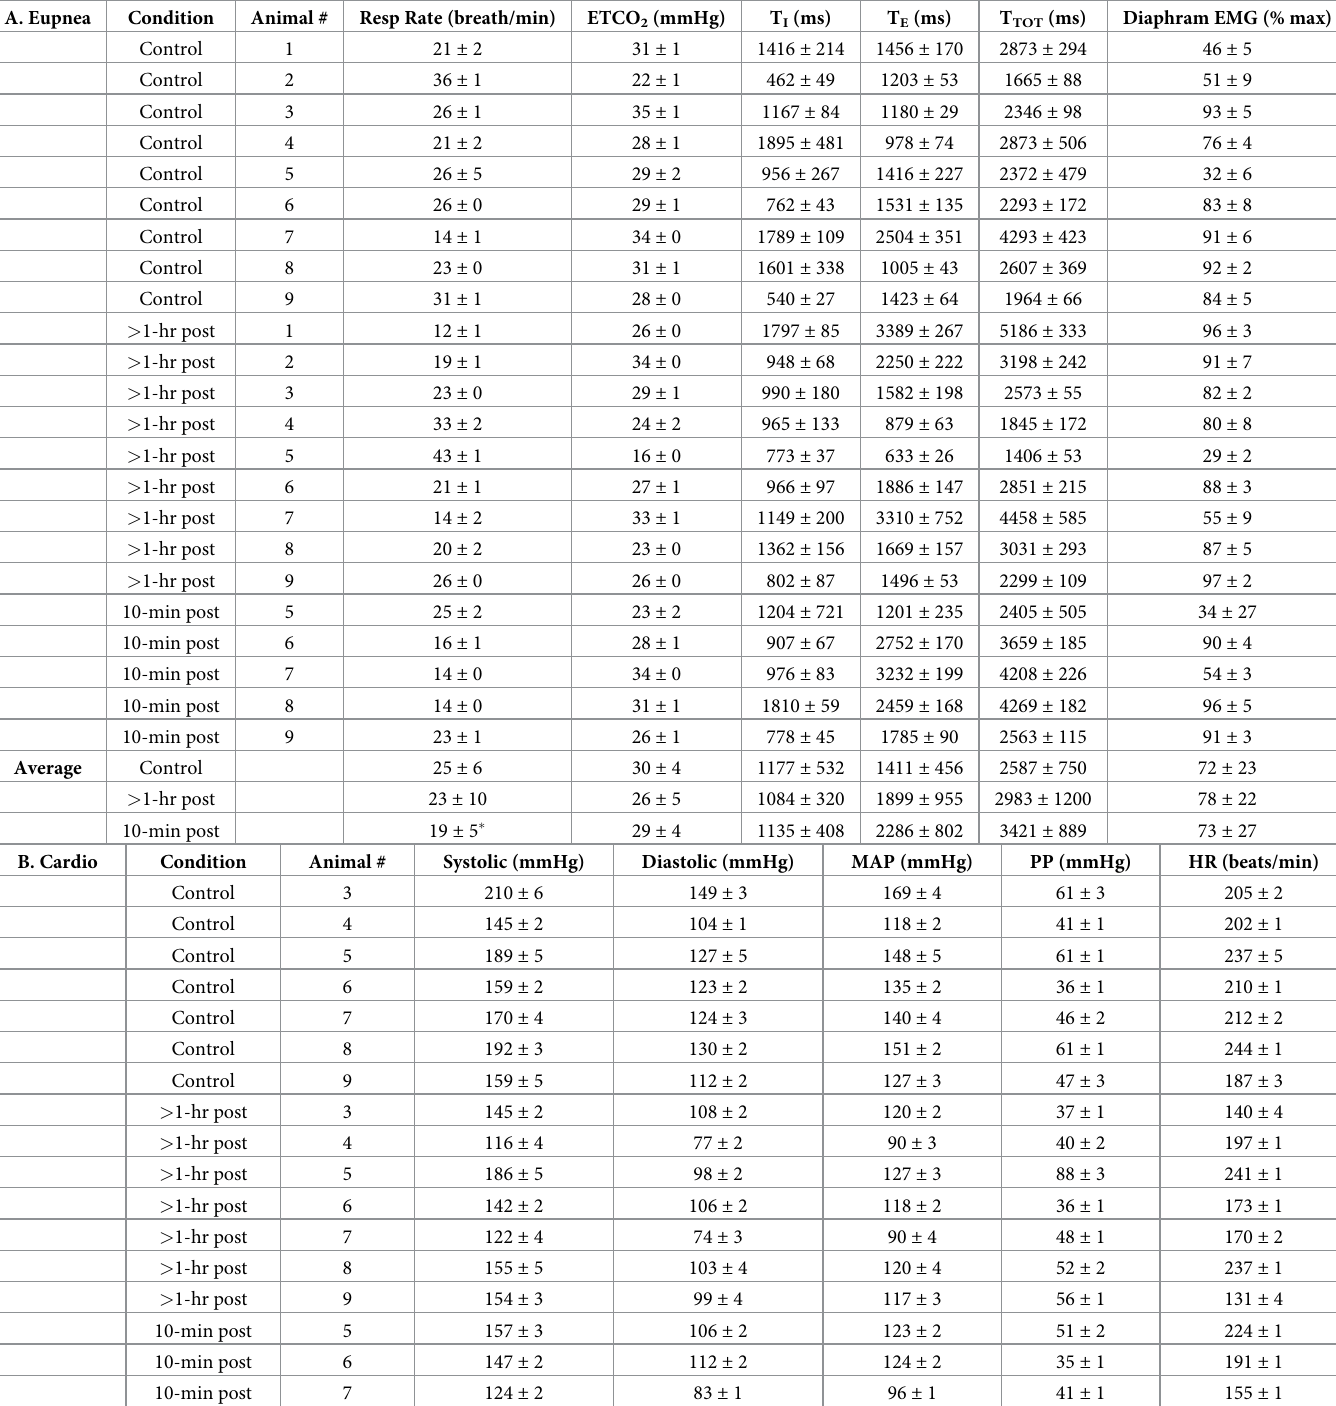
Table 2. Raw means and standard deviations of cardiorespiratory parameters measured preceding a cough trial. (A.) Respiratory parameters measured include respi- ratory rate (breaths/min), end-tidal CO 2 (ETCO 2 , mmHg), T I , T E , and T TOT phases of breathing (ms), and diaphragm EMG amplitude (% maximum). (B.) Cardiovascular measures were also recorded including systolic, diastolic, mean arterial pressure (MAP), and pulse pressure (PP) (mmHg) as well as heart rate (beats/min) preceding each cough trial. A.